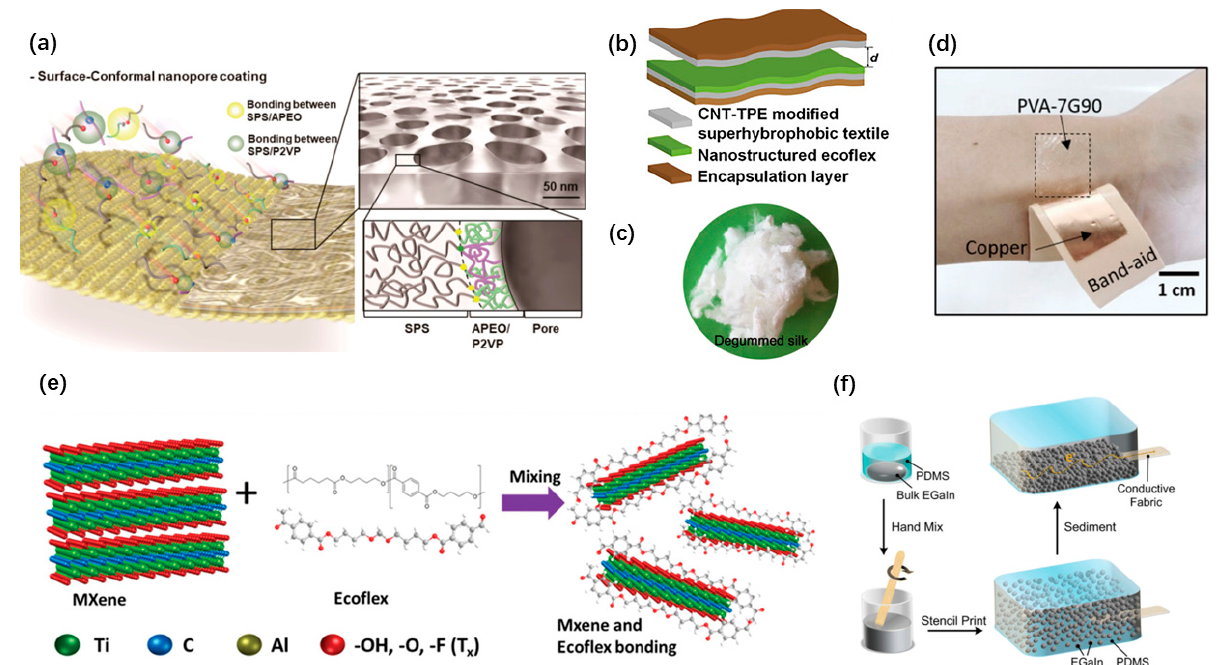
Figure 2. Materials of wearable and implantable TENGs. ( a ) Surface-conformal nanoporous films coated on textiles. Reproduced with permission from Ref. [59]. Copyright © 2020, American Chemical Society. ( b ) A textile TENG with super-hydrophobic coating. Reproduced with permission from Ref. [44]. Copyright © 2020, Wiley-VCH. ( c ) Natural silk fibers